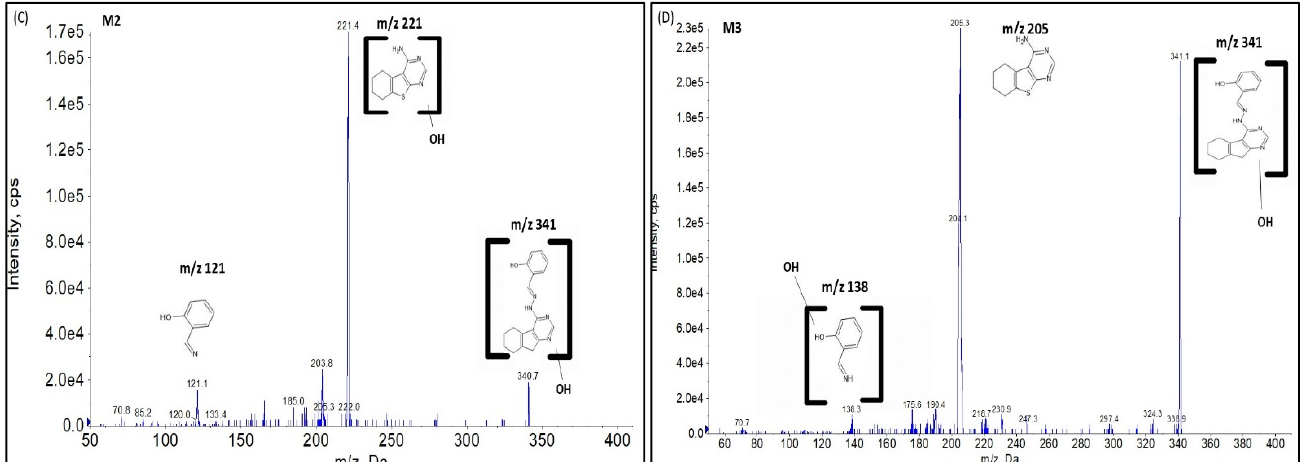
Figure 6. ( A ) Product ion scan Chromatogram m/z 341. ( B ) MS2 Spectra of M1 (retention time: 1.66 min). ( C ) MS2 Spectra of M2 (retention time: 1.76 min). ( D ) MS2 Spectra of M3 (retention time: 1.96 min).